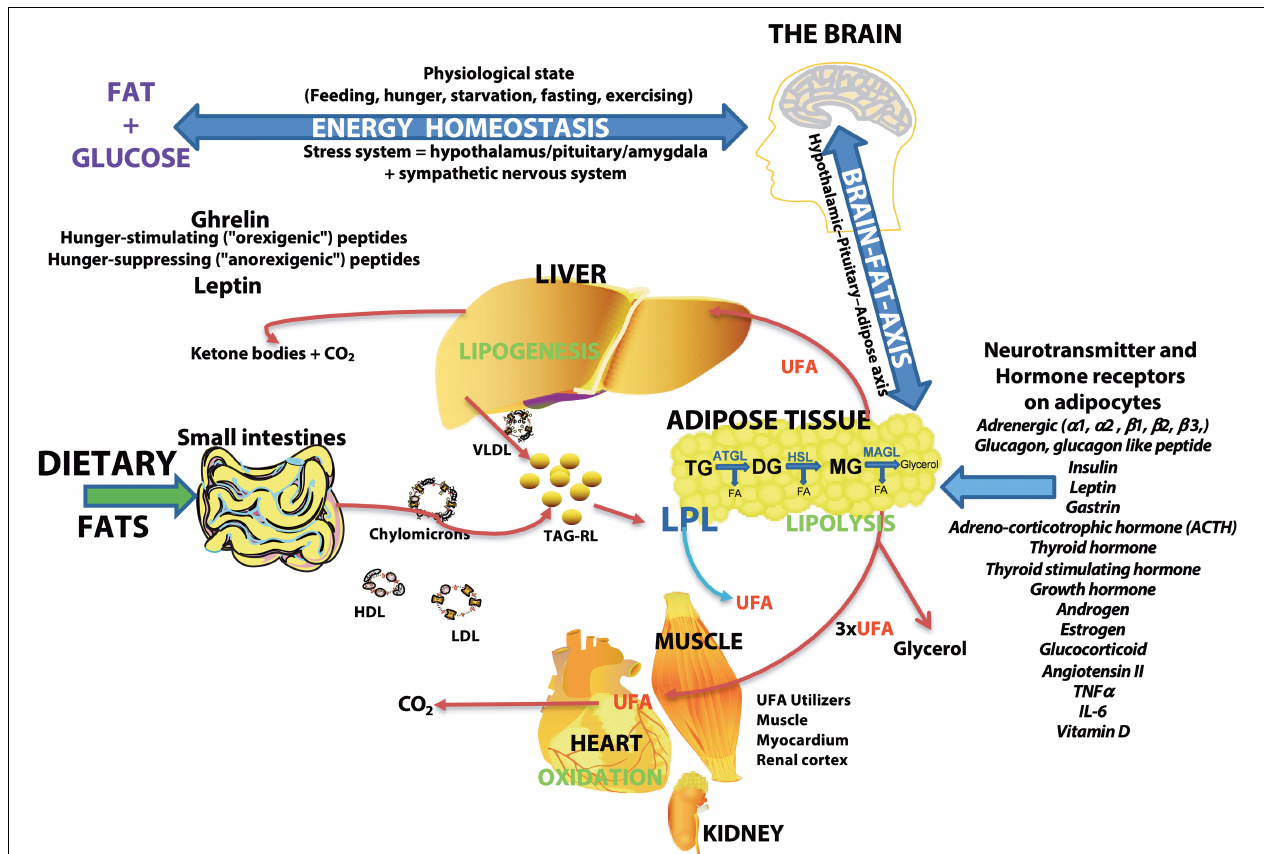
FIGURE 7 | Schematic overview of the major sites of lipogenesis and lipolysis and their potential roles in generating unesterified fatty acids–The brain regulates the body’s physiologic state and is involved in energy homeostasis via hunger-stimulating (ghrelin) or hunger-suppressing (leptin) peptides. Dietary fats or fatty acids synthesized in cells are packaged into triacylglycerol-rich lipids (TAG-RL) or are associated with lipoproteins (VLDL, LDL, chylomicrons, and HDL) for transport to tissues. Extra TAG-RL is stored in adipose tissues. Studies show the expression of several neurotransmitters and hormone receptors in adipose tissue, suggesting an interaction of the brain and adipose tissue via the hypothalamic-pituitary-adipose axis or the Brain-Fat-Axis. In times of high energy demands or low blood glucose, sympathetic pathways may stimulate the release of fatty acids through receptor signaling pathways involving PKA/PKG, PKC, tyrosine kinase, and ERK1/ERK2. Unesterified fatty acids (UFA) are released from adipose tissues by lipoprotein lipase (LPL) or a combination of other lipases [adipose triglyceride lipase (ATGL), hormone-sensitive lipase (HSL), and monoacylglycerol lipase (MAGL)] that are regulated by neurotransmitters, hormones, and neuropeptides. The final lipolysis products are a glycerol molecule and three fatty acids. The released fatty acids are utilized by organs (heart, muscle, and renal cortex) for energy or modified in the liver (lipogenesis) or used to form ketone bodies. Lipolysis is stimulated by adrenergic signaling and glucagon and is inhibited by insulin. Thus, insulin resistance associated with migraines may result in the buildup of unesterified fatty acids in